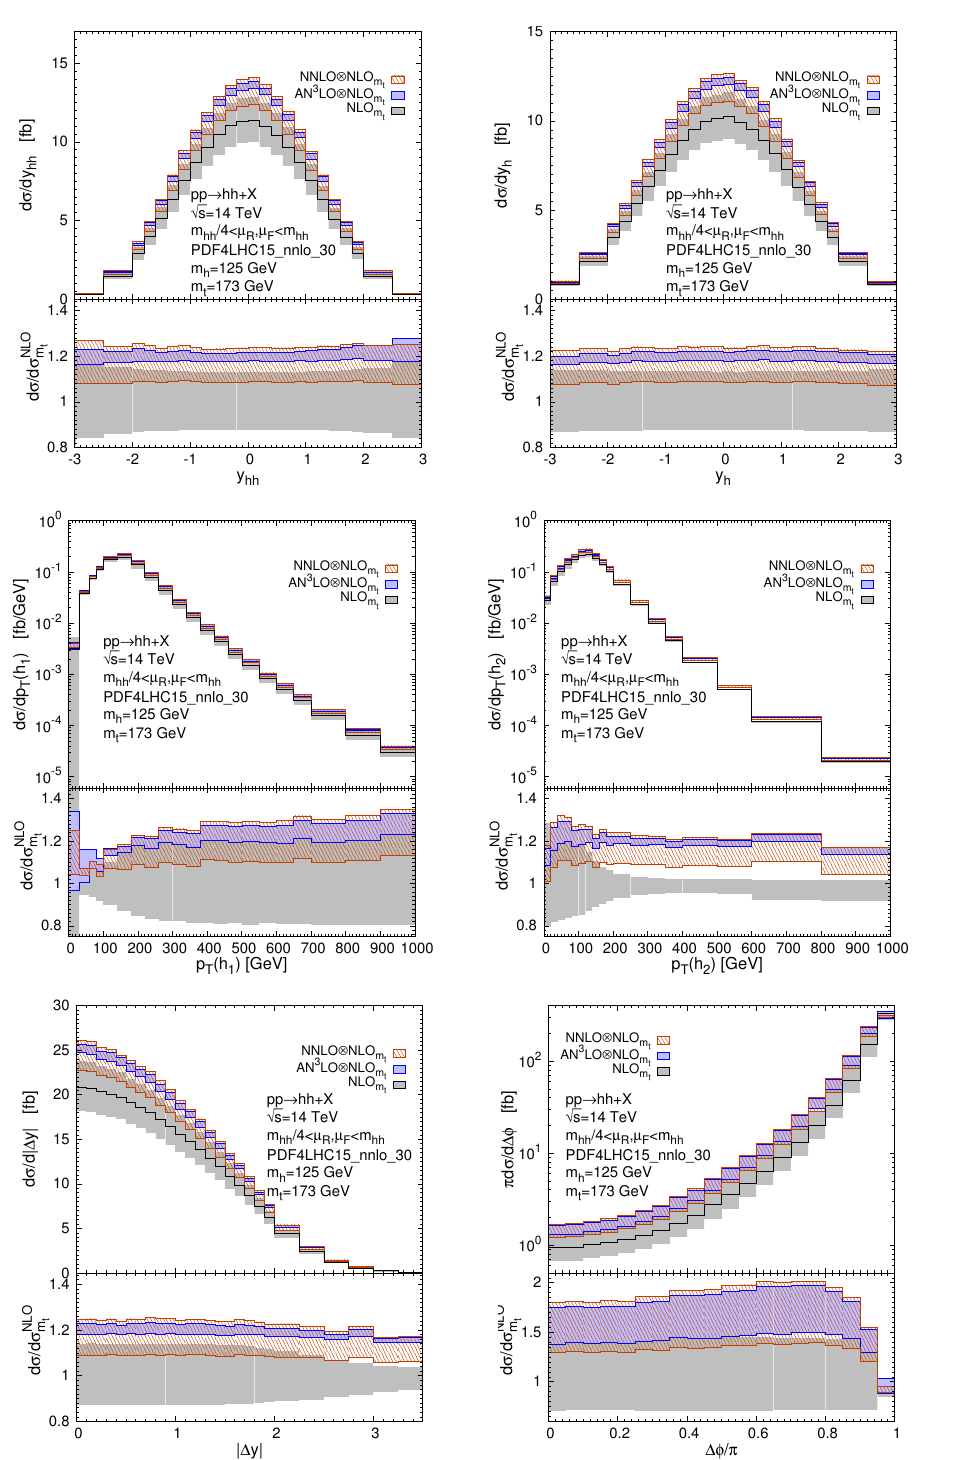
Figure 17 . Various distributions [ y hh (up left), y h (up right), p T ( h 1 ) (middle left), p T ( h 2 ) (middle right), j (cid:1) y j (low left), and (cid:1) (cid:30) (low right)] with top-quark mass e(cid:11)ects for the Higgs boson pair p production in proton-proton collisions at s = 14 TeV.